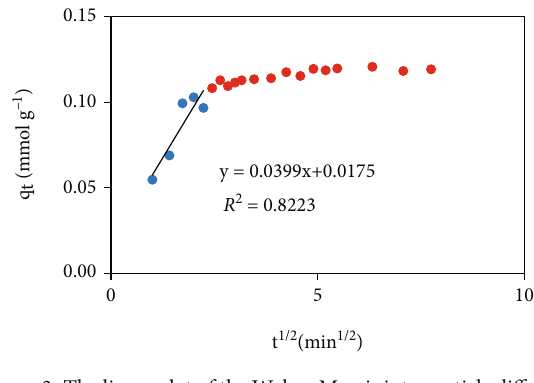
Figure 3: The linear plot of the Weber-Morris intraparticle di ff usion model of MV adsorption (mass of adsorbent = 0 : 020 g; volume of MV solution = 10 : 0 mL; concentration of MV = 100 mgL -1